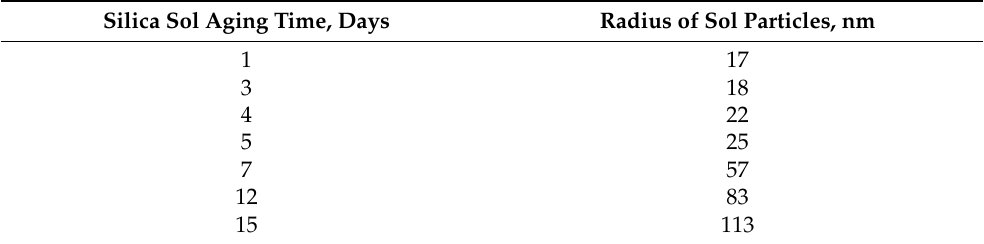
Table 2. The values of the radius of the sol particles depending on the aging period. Silica Sol Aging Time, Days Radius of Sol Particles, nm